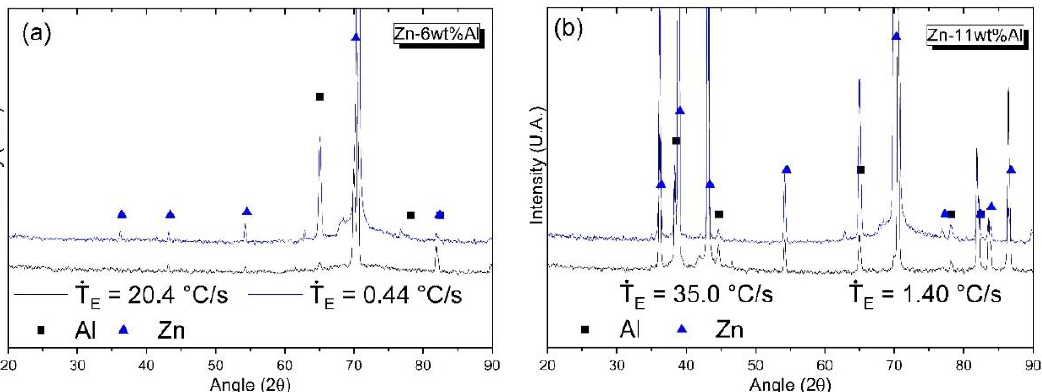
Figure 12. X-ray diffractograms of samples from the DS casting subjected to different cooling rates ( a ) Zn-6wt.%Al and ( b ) Zn-11wt.%Al. For better visualization of the thermal parameters effect on the microstructure, optical micrographs of transverse and longitudinal sections were chosen at three different positions along the length of the DS castings to illustrate the evolution of the microstructures for high, medium and low solidification cooling rates (Figures 13 and 14). The values of